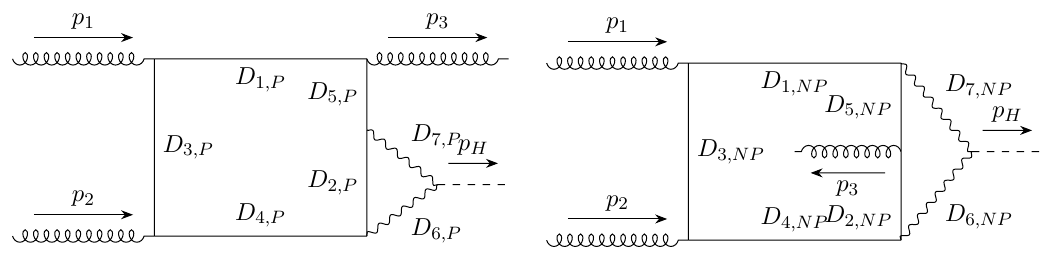
= 0 , ( p 1 + p 2 − p 3 ) 2 = m 2 , and m V denotes the gauge boson i H